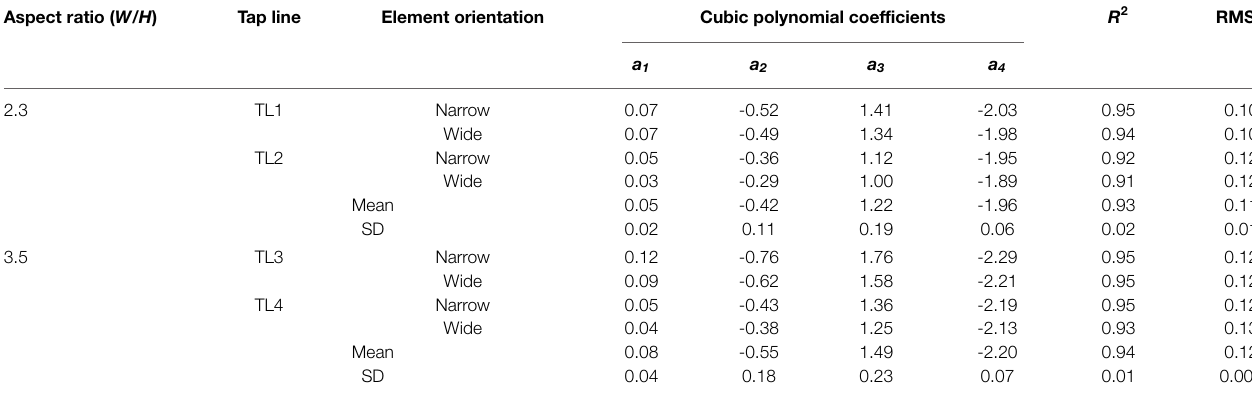
TABLE 6 | Polynomial coefficients from third-order curve fitting of peak pressures as a function of the normalized mean reattachment length. Aspect ratio ( W / H ) Tap